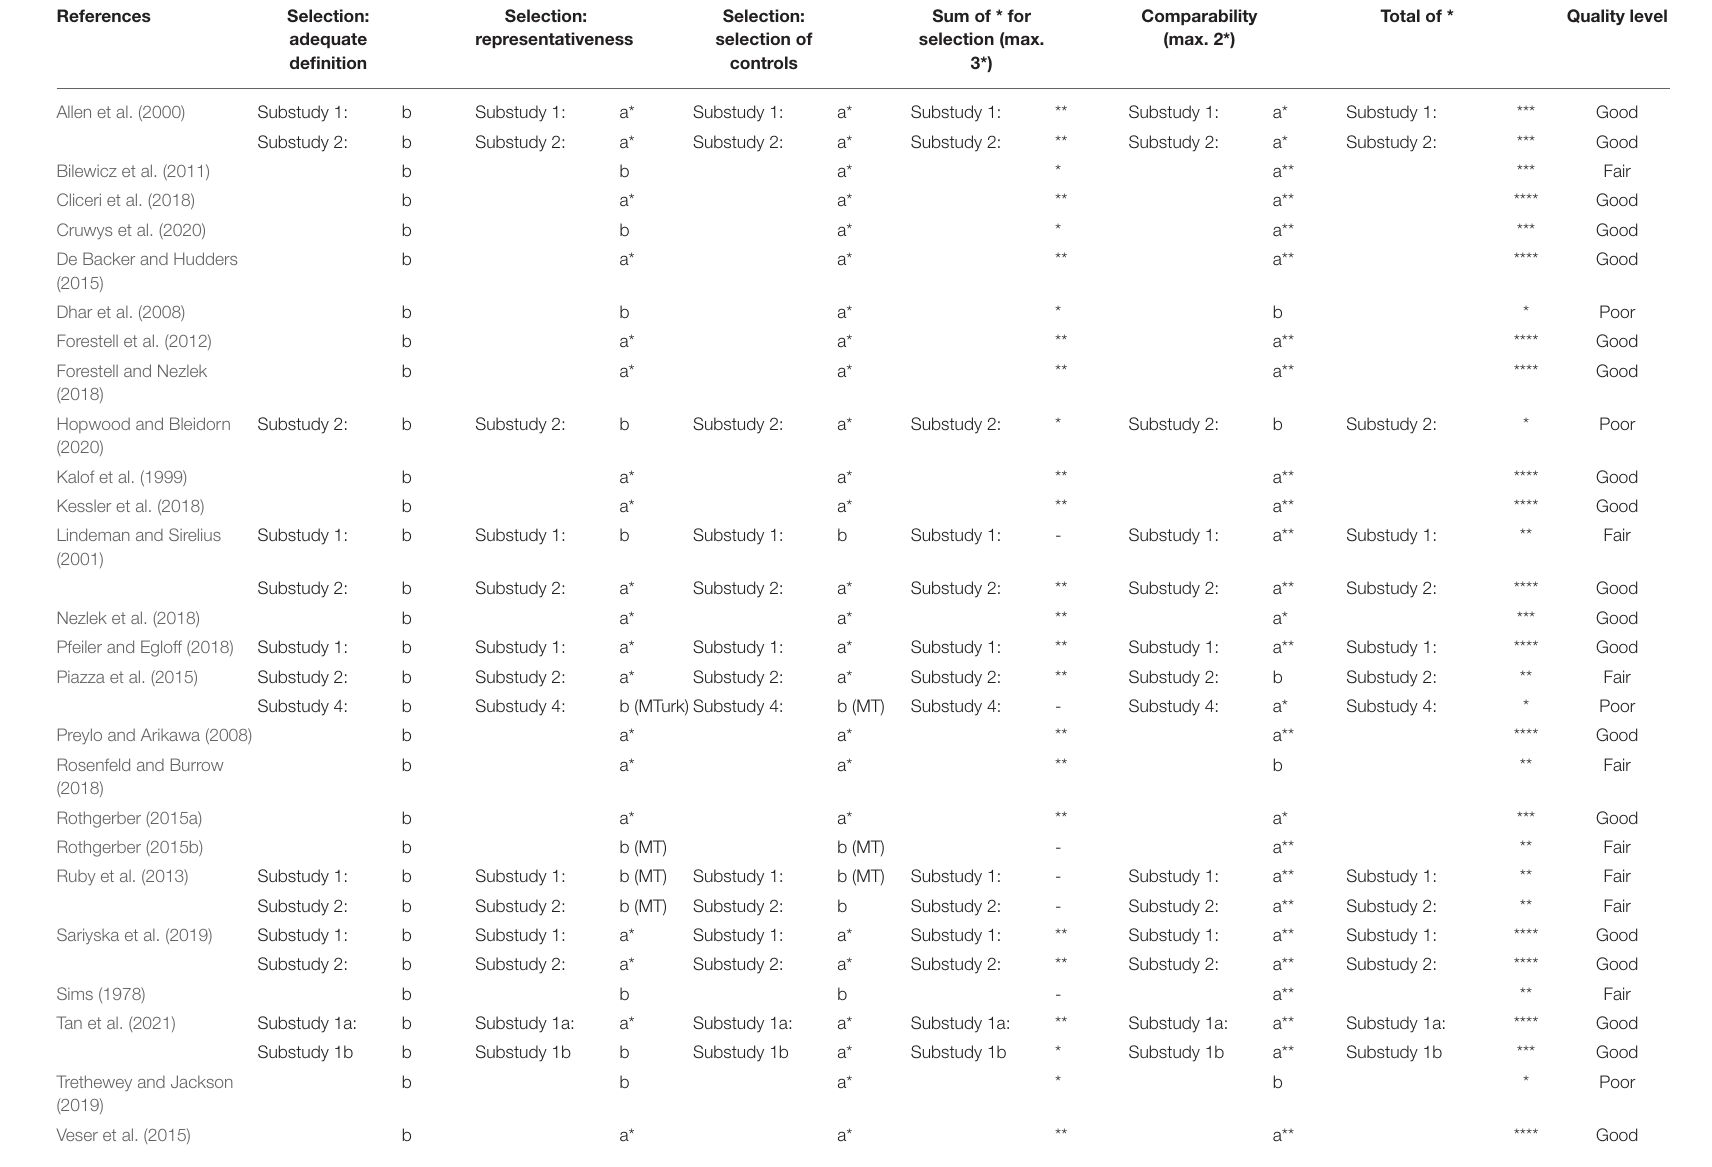
TABLE 2 | Newcastle-Ottawa scale [76] for case-control studies ( * = high quality